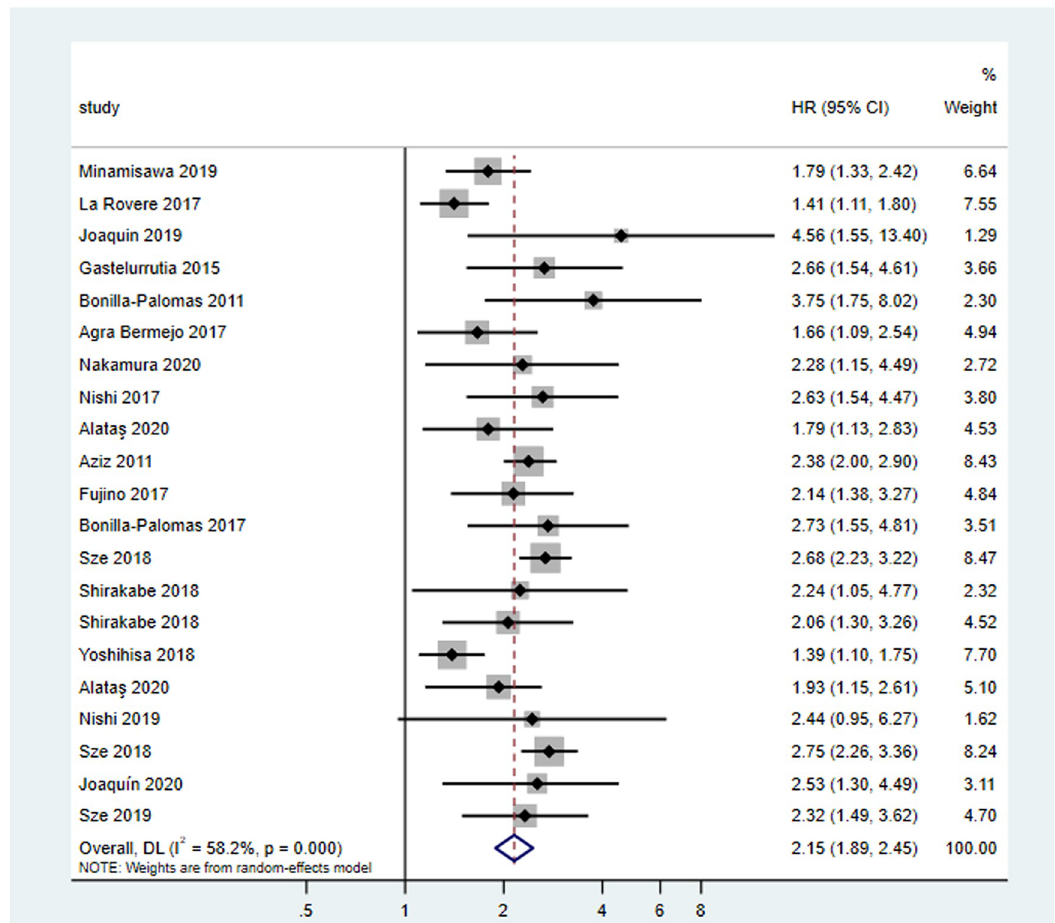
Fig 3. Forest plots of malnutrition prognosis in patients with chronic heart failure. HR: Hazard Ratio.